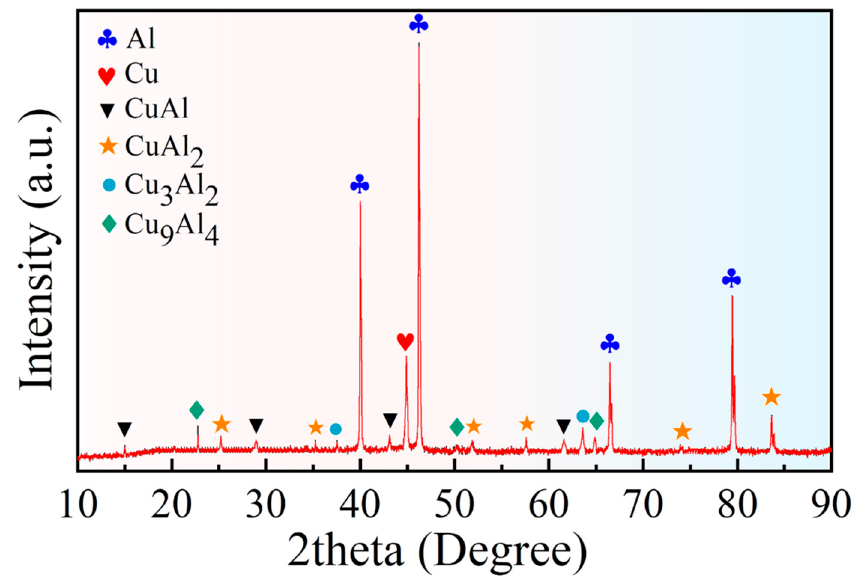
Figure 6. XRD test of Cu/Gr-Al-Cu/Gr laminated composites cross section.